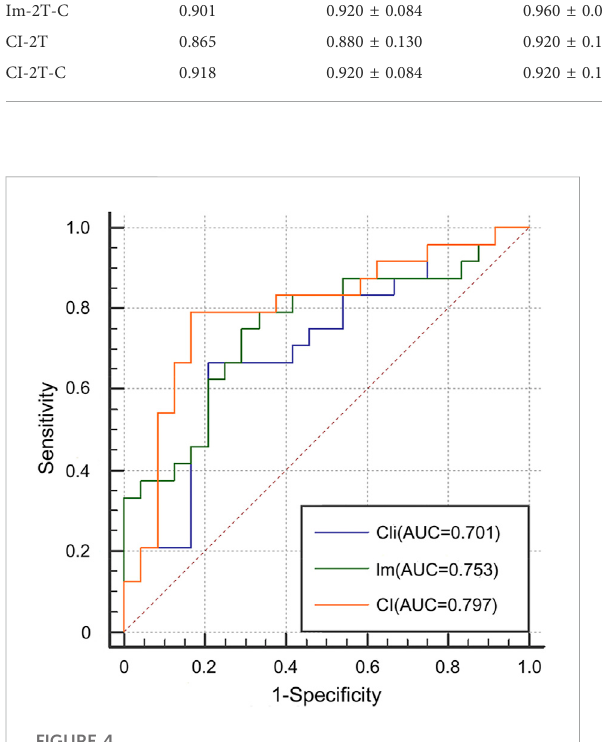
FIGURE 4 ROC curves for the Cli, Im, and CI networks to show the effectiveness of multimodal data fusion.